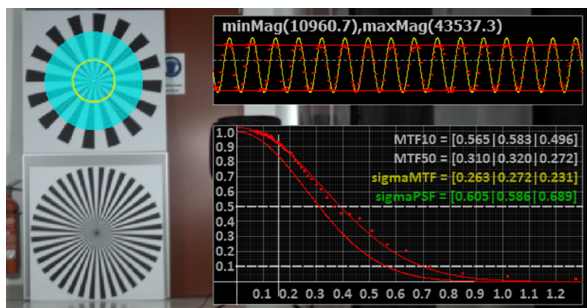
Figure 1. Designated test pattern Siemens star (left), radial modulation analysis (top-right), resulting MTF and PSF